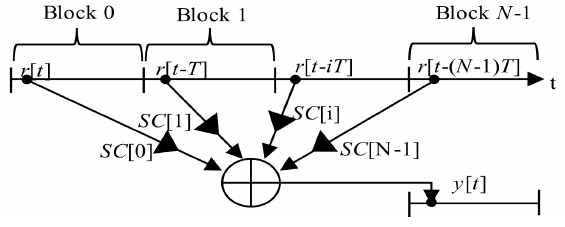
Figure 7. Functional diagram of mPCA .